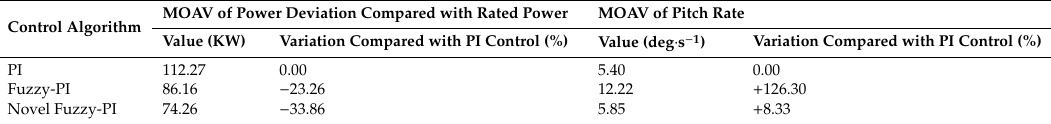
Figure 10. The simulation results under extreme turbulent wind conditions. Table 6. Analysis of simulation results under extreme turbulent wind conditions.